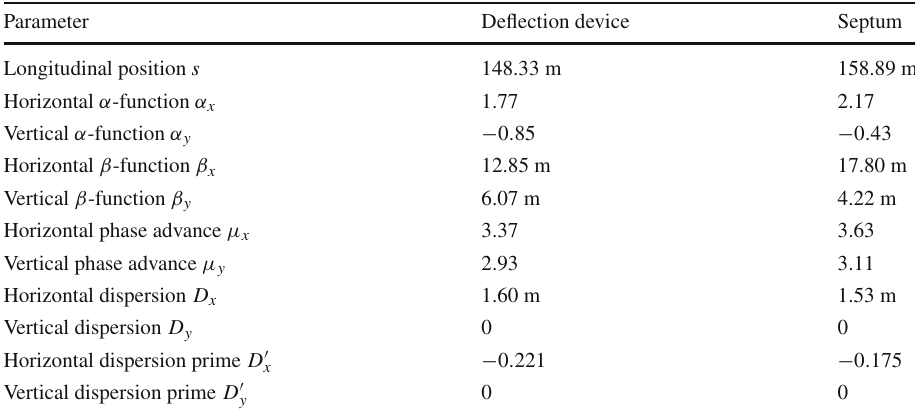
Table 2 Optics parameters at the positions of the deflection device and the septum